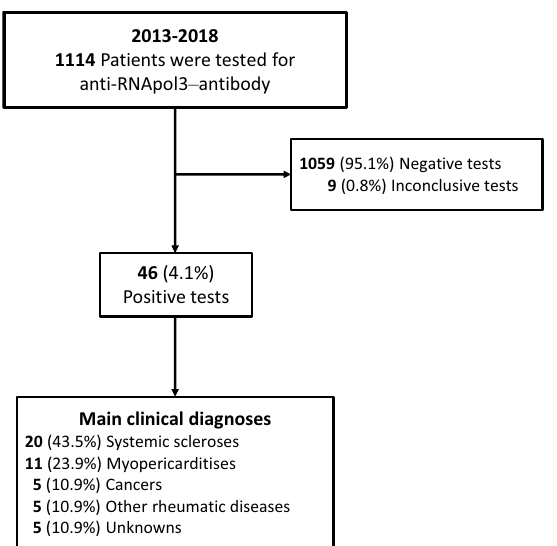
Fig. 1 Distributions of the 152 episodes of definite/probable and no catastrophic antiphospholipid syndrome (CAPS) requiring intensive care unit (ICU) admission, diagnosed in 134 antiphospholipid syndrome patients, and their attributed fatalities, with respective reasons for not being classified as definite